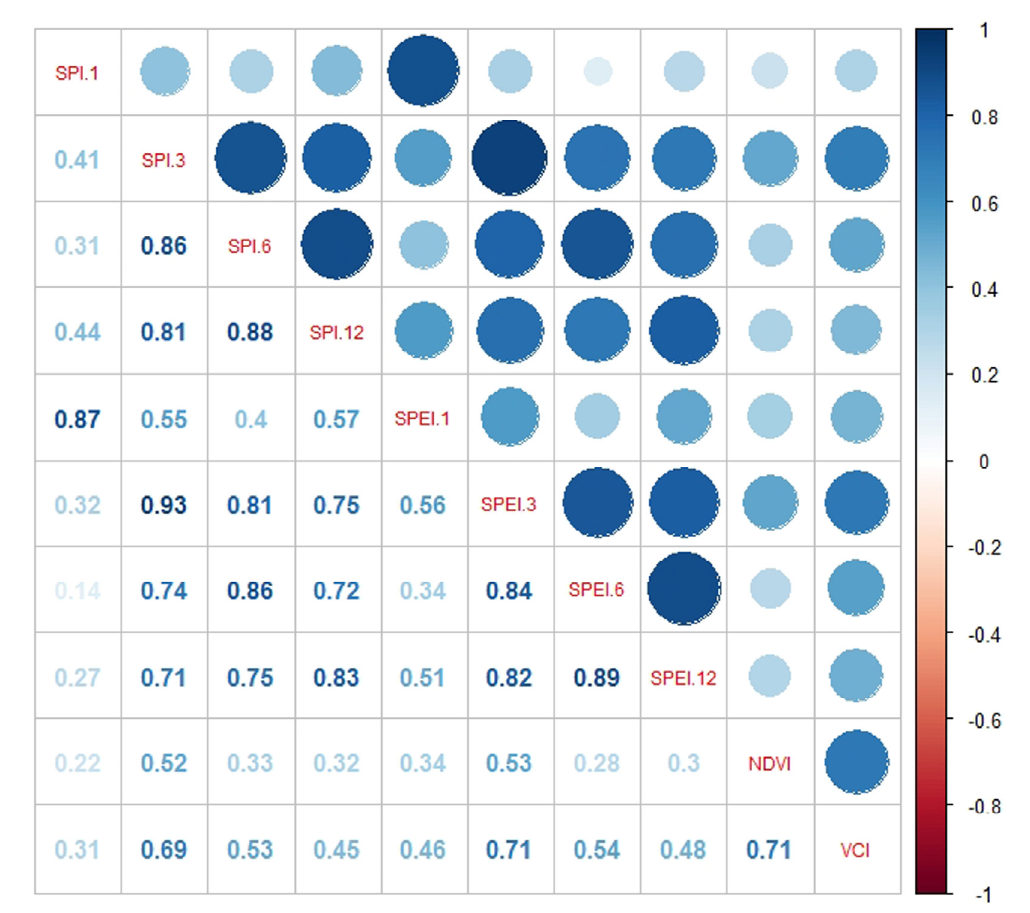
Figure 9. The correlations among the vegetation indexes and the SPI / SPEI at 1-, 3-, 6-, and 12-month timescales. All coefficients are significant with p < 0.05.